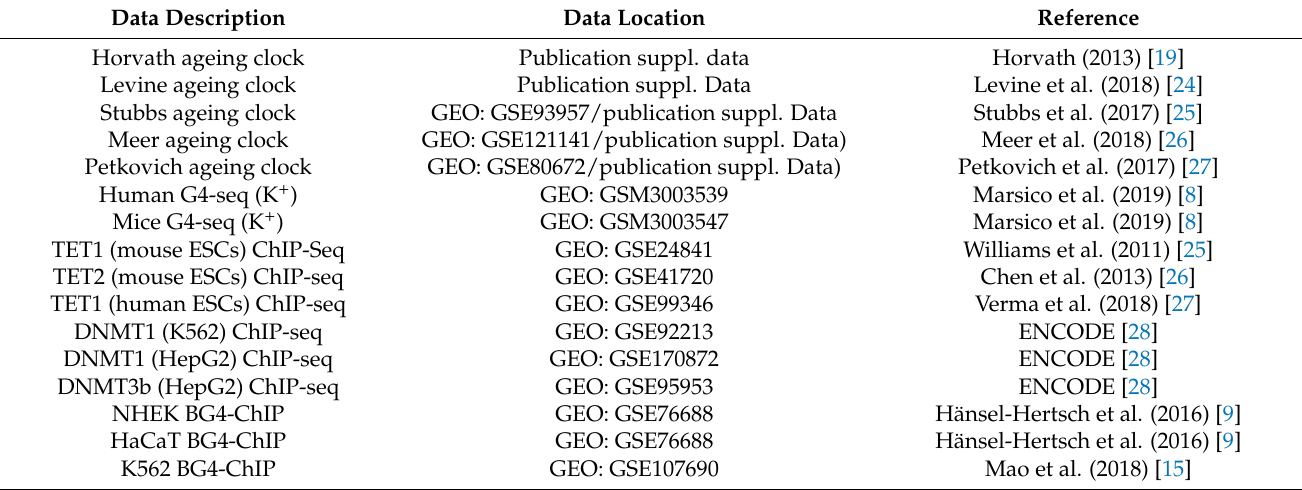
Table 1. Details of all datasets used in this